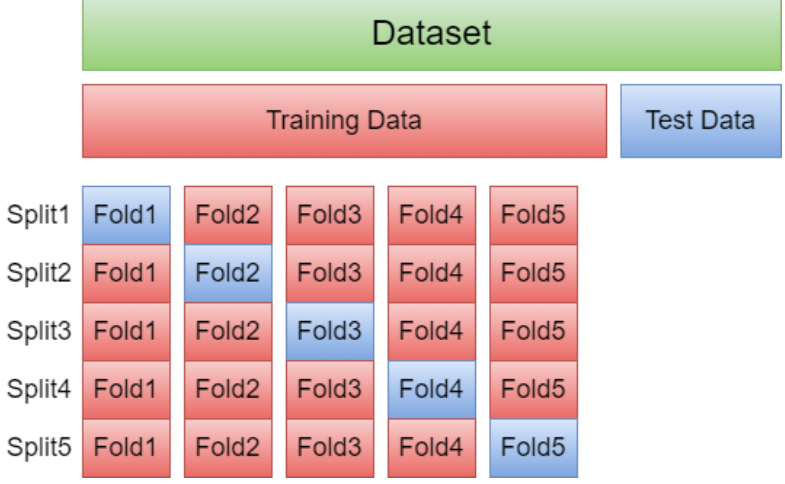
Figure 8. Five-fold